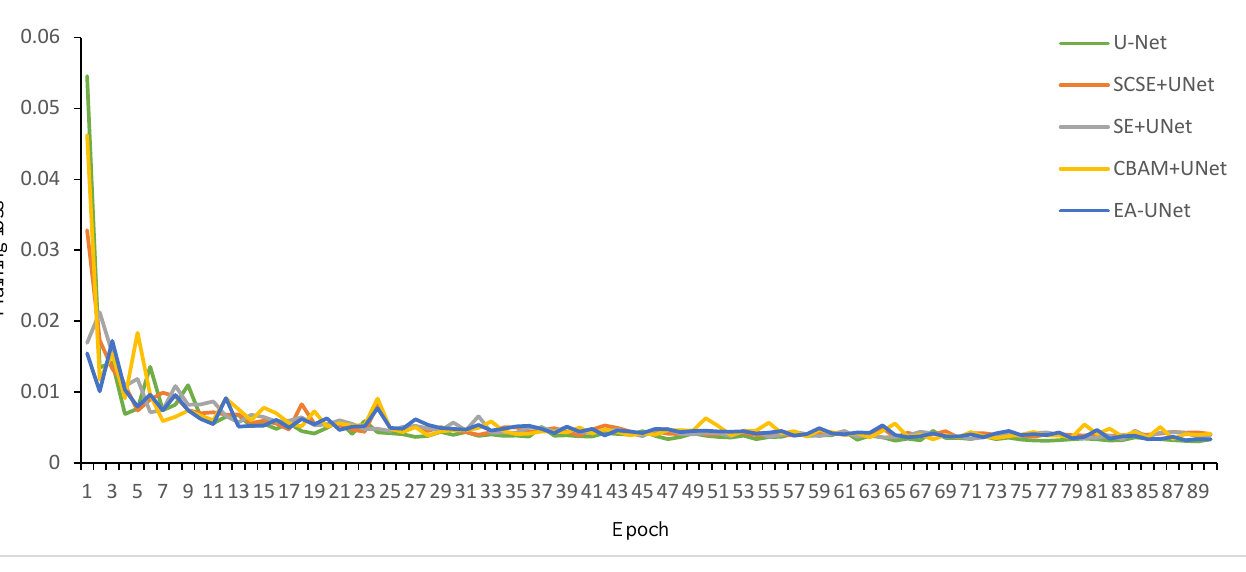
Figure 6. Comparison of changes in loss function for different attention modules.